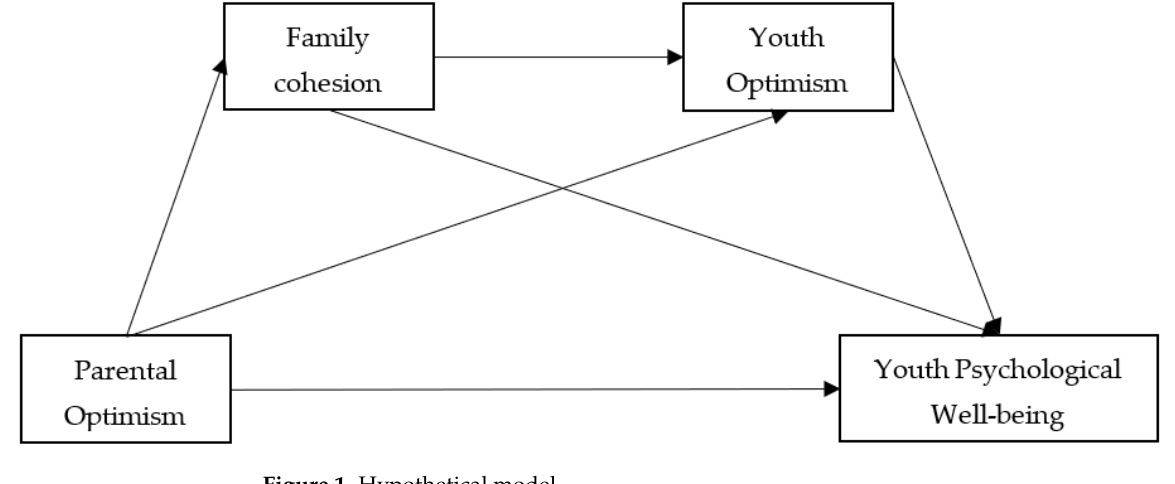
Figure 1. Hypothetical model.